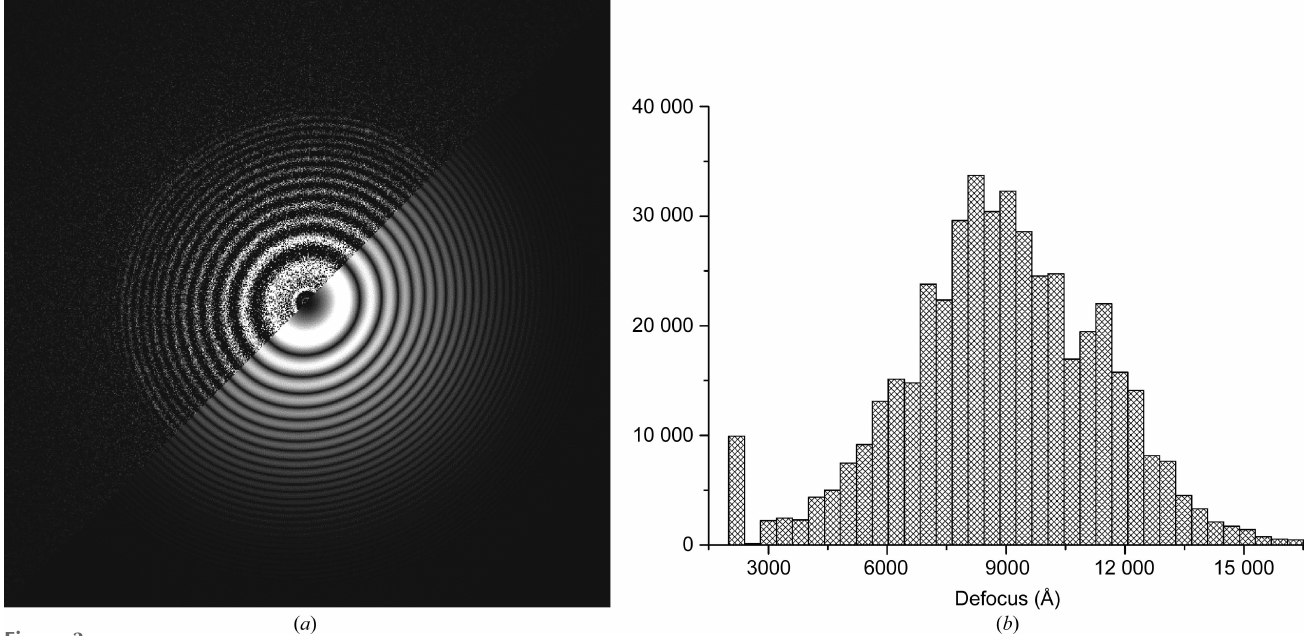
Figure 3 ( a ) Selected class average of individual spectra with fitted theoretical spectrum. Top left, experimental class-average spectrum (1280 (cid:4) 1280 patches). Bottom right, theoretical CTFamplitudes at a defocus of 7913/9047 A˚ (astigmatism of 1134 A˚ at an angle of 133 (cid:5) ). Thon rings in good spectra are visible to beyond (cid:2) 2/3 of the Nyquist frequency, corresponding to a resolution of (cid:2) 3.1 A˚ . ( b ) Histogram of the defocus values of (cid:2) 450 000 movie-frame patches. The peak at the low-defocus edge of this histogram corresponds to outliers with a defocus less than 0.22 m m (the search limit), which were